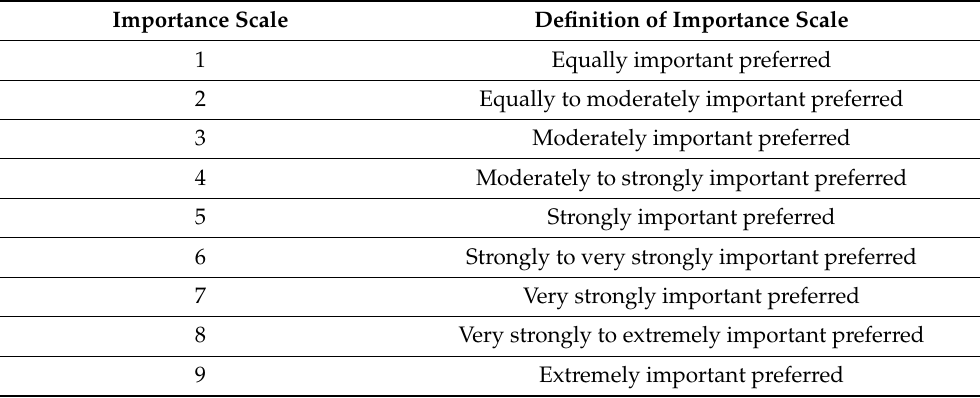
Table 5. The importance values of numerical